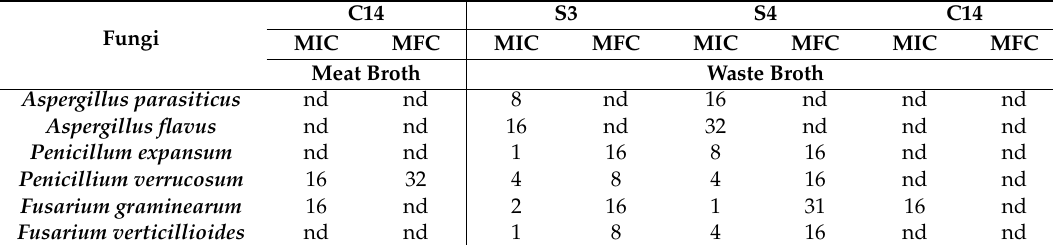
Figure 4. Antifungal activity represented by the halo of inhibition in Petri dishes of: ( A ) fermented MB against P. expansum , ( B ) fermented MB against A. flavus , and ( C ) fermented WB against A. parasiticus . against P. expansum , ( b ) fermented MB against A. flavus , and ( c ) fermented WB against A. parasiticus . Table 3. Minimum Inhibitory Concentration (MIC) and Minimum Fungicide Concentration